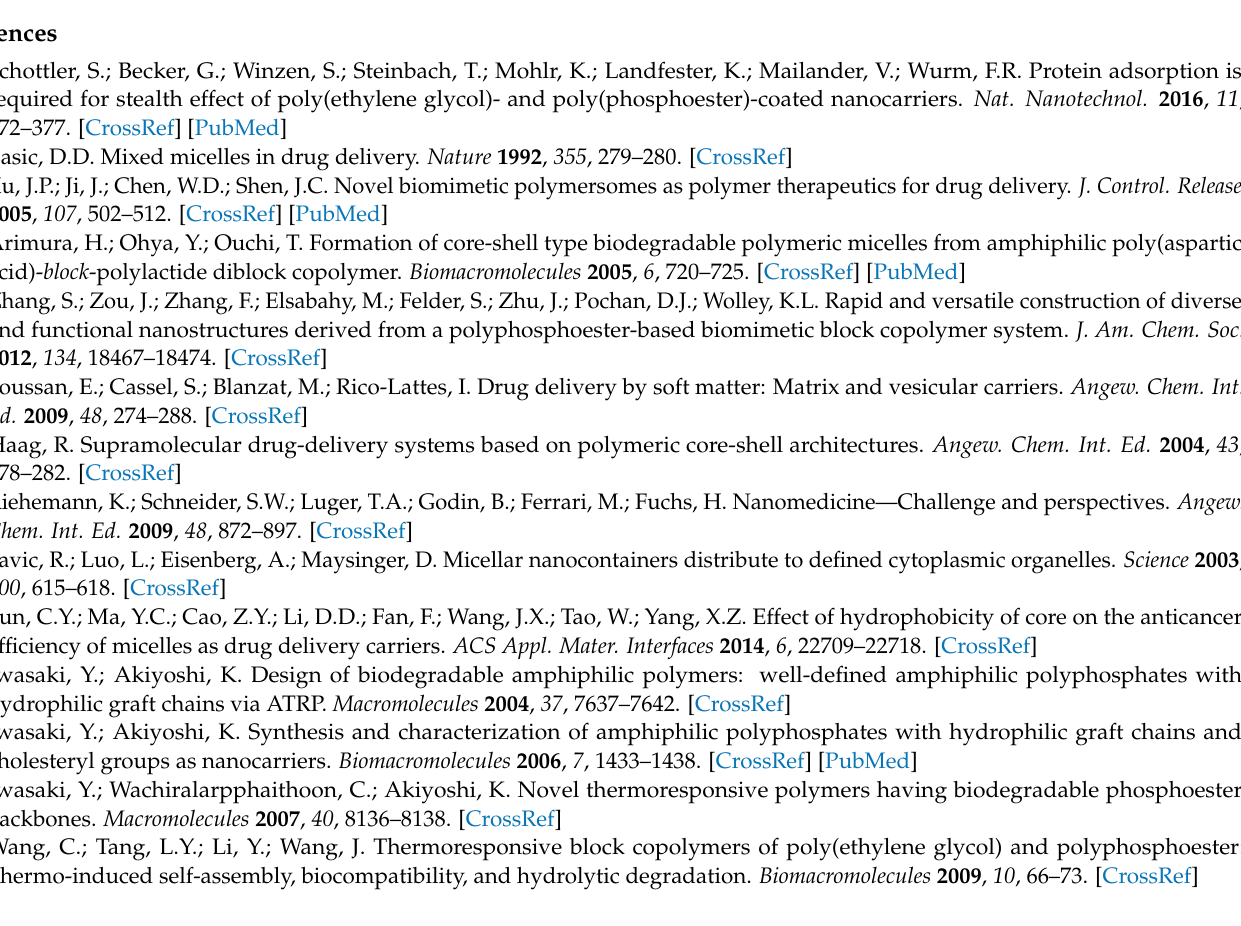
H-phosphonate), based on PEG 400. Figure S2: 13 C{H} NMR spectrum of poly(oxyethylene H- phosphonate), based on PEG 400. Figure S3: 31 P{H}NMR spectra of poly(oxyethylene H-phosphonate), based on PEG 400. Figure S4: 31 P NMR spectra of poly(oxyethylene H-phosphonate), based on PEG 400. Figure S5: 31 P NMR spectra of poly(chloroxyethylene phosphate), based on PEG 400, signal for phosphorous atom in the repeating units. Figure S6: 31 P{H} NMR spectra of poly(methyloxyethylene phosphate, based on PEG 400. Figure S7: 31 P NMR spectrum of poly(methyloxyethylene phosphate), based on PEG